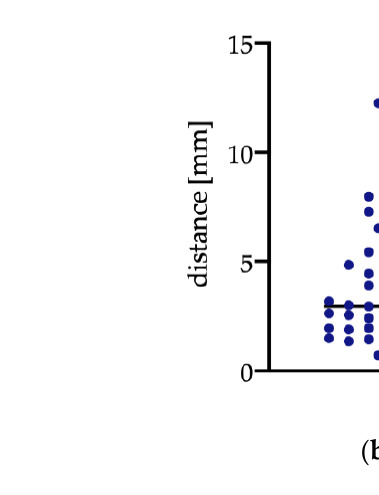
Figure 4. Scatterplots with median line of ( a ) Hausdor ff distance. Median: 8.1 mm, mean ± SD: 8.1 ± 2.9 mm. ( b ) Euclidean distance of geometric center of gravity. Median: 3.0 mm, mean ± SD: 3.7 ± 2.5